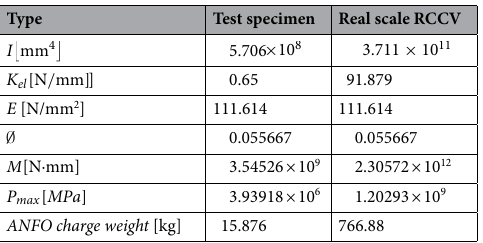
Table 4. Calculated results of the test specimen and real scale